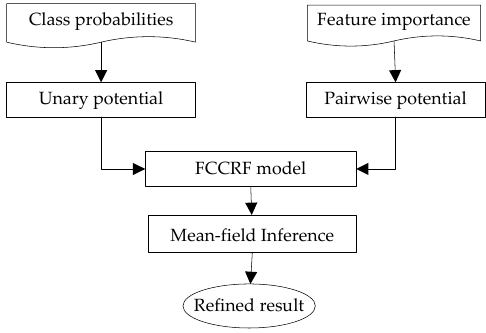
Figure 8. Flowchart of the FCCRF-based refinement. The class probabilities and the feature importance indicators generated by the trained RFE model are used to construct the unary potential and the pairwise potential,